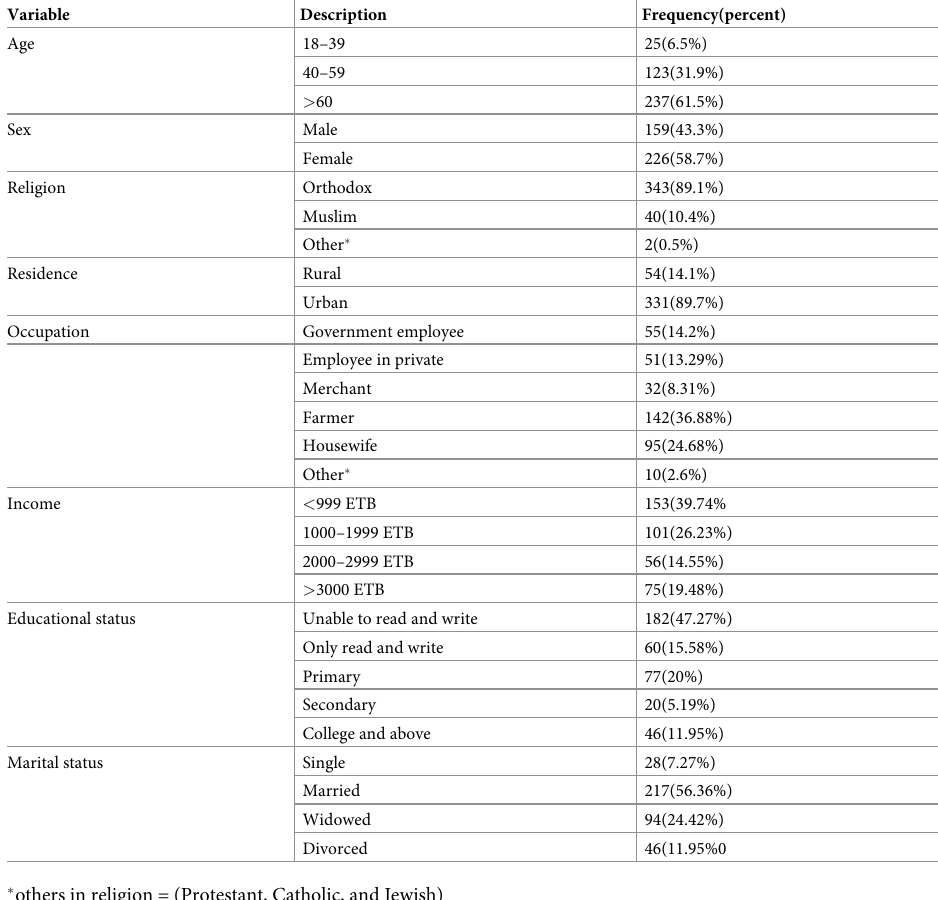
Table 1. Sociodemographic characteristics of hypertensive patients in Gondar public health facilities, North West Ethiopia,